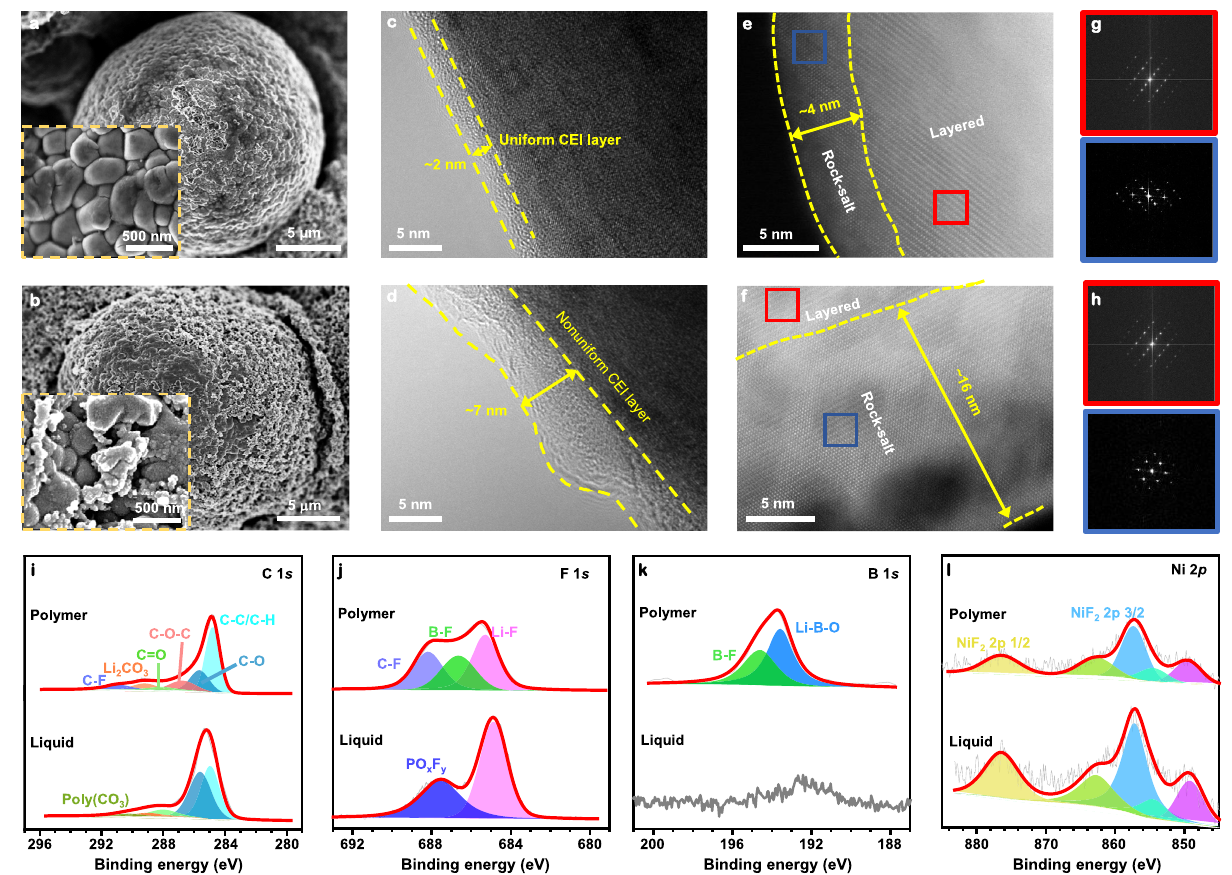
Fig. 6 | Ex situ postmortem physicochemical characterizations of NCM811- based electrodes cycled in liquid and polymer electrolytes. a , b SEM images of NCM811 particles using the designed polymer electrolyte ( a ), and the liquid elec- trolyte ( b ). c , d TEM ofNCM811particles using the polymer electrolyte( c ),and the liquid electrolyte ( d ). e – h High-resolution TEM images and corresponding FFT for